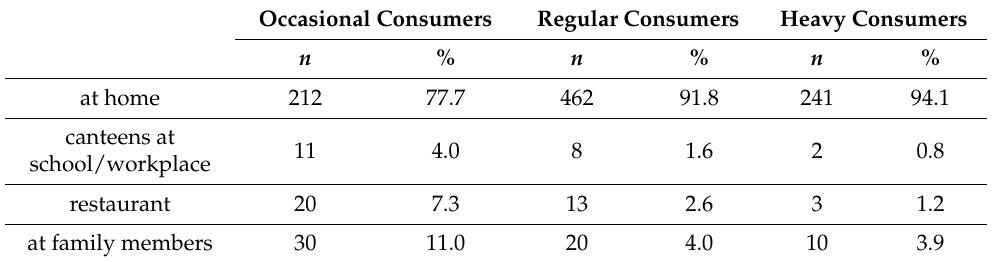
Table 8. Places of edible mushrooms consumption in individual segments of edible mushrooms consumers.